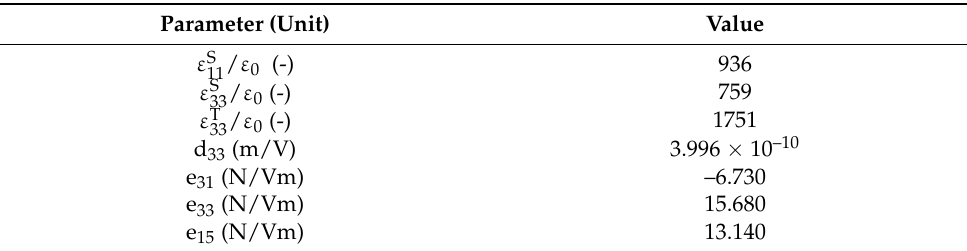
Table 3. Piezoelectric properties (relative permittivity and piezoelectric constants e and d) [51] ( ε 0 = 8.854 × 10 –12